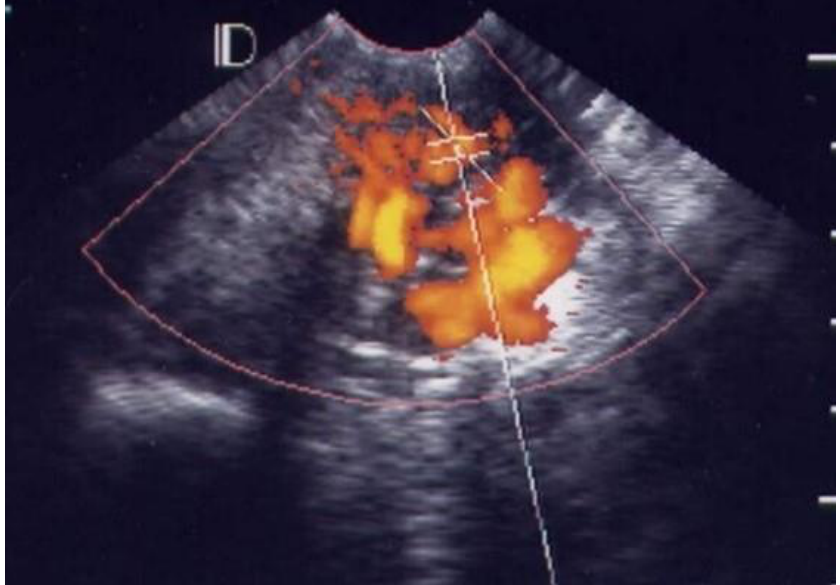
Figure 4. GRADE 4. A case of 18 years old young lady with pelvic inflammatory disease, many vascular spots involved the endocervical canal and whole endocervix.